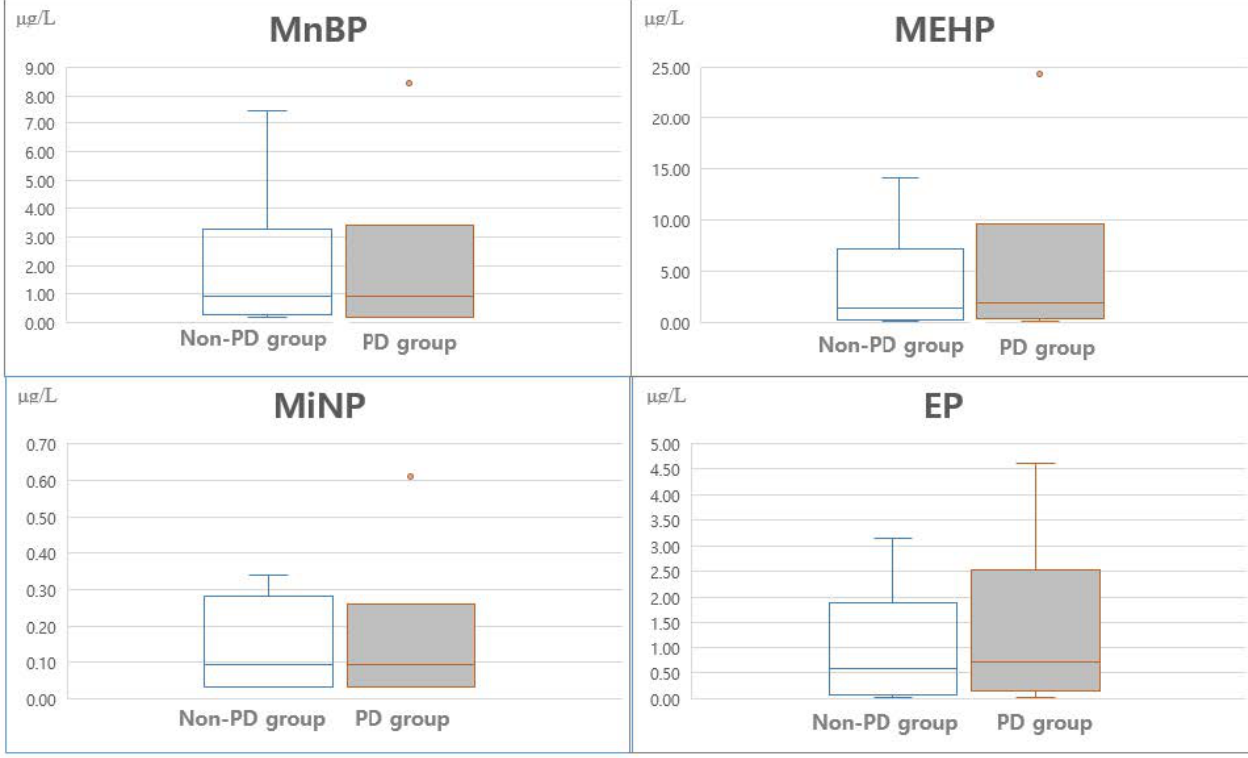
Figure 1. Concentrations of MnBP, MEHP, MiNP, and EP according to the postpartum groups. MnBP, mono-N-butyl phthalate; MiNP, mono-isononyl phthalate; MEHP, mono (2-ethylhexyl) phthalate; EP, ethyl-paraben. Table 4. Results of the logistic regression for the association between chemical concentrations and the